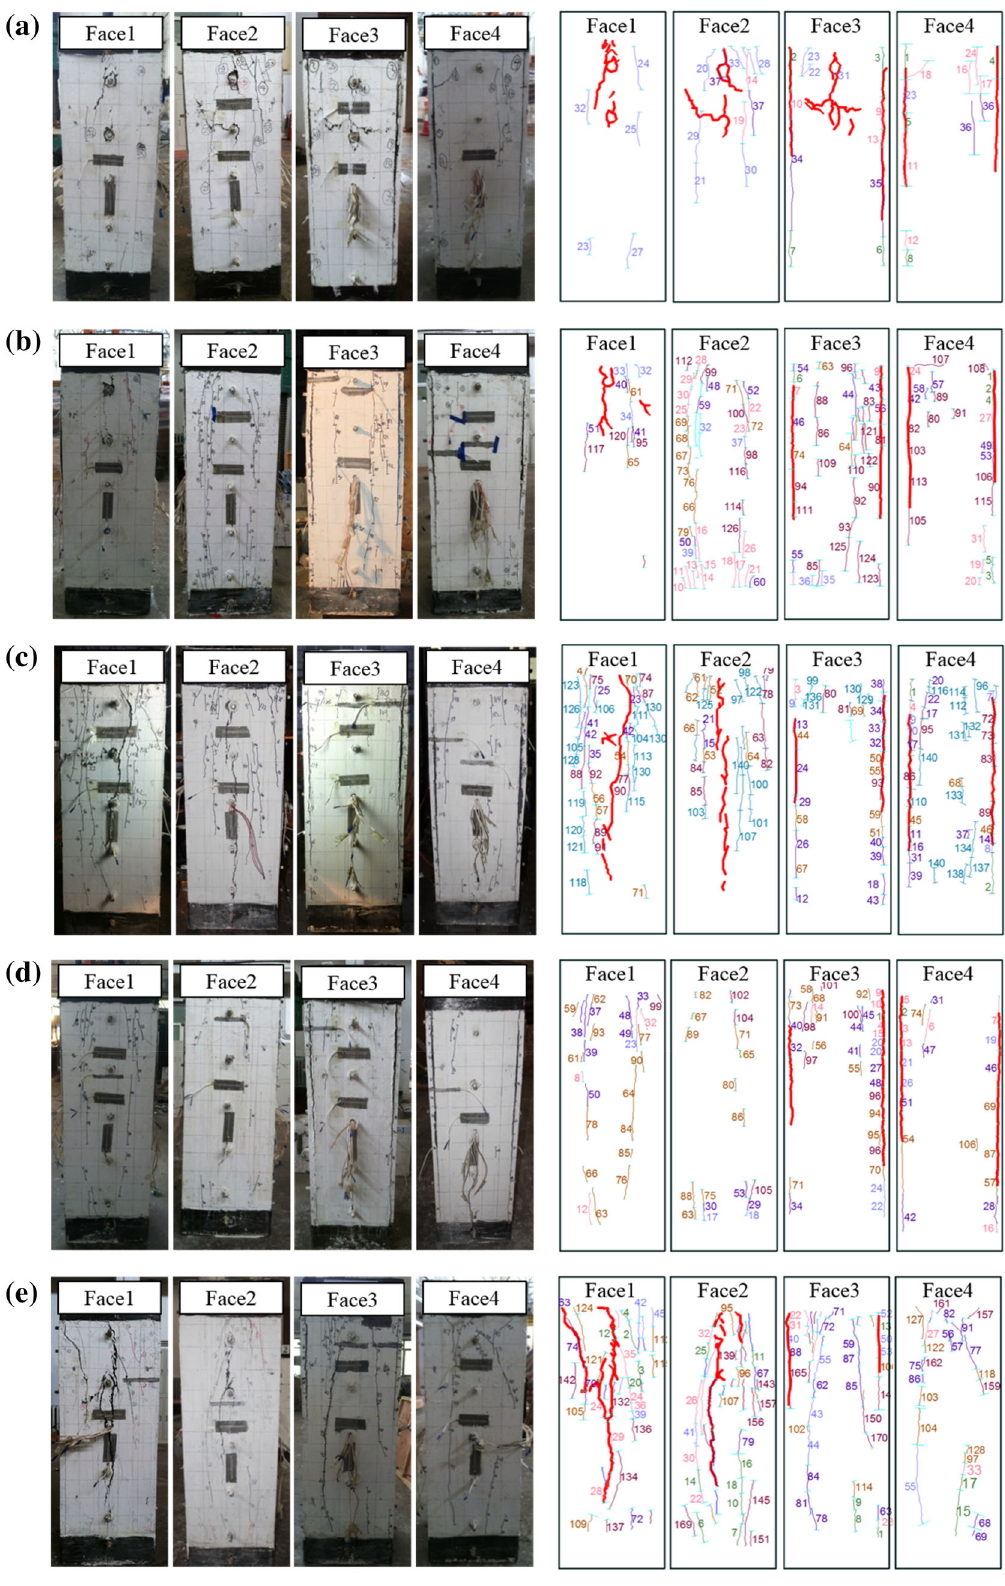
Fig. 6 Failure modes and crack patterns of column specimens: a HCC1 (control: V f = 1.5%, s = 100 mm, wire-mesh), b HCC2 ( V f = 2.0%), c HCC3 ( s = 200 mm), d HCC4 ( V f = 2.0%, s = 200 mm), and e HCC5 (no